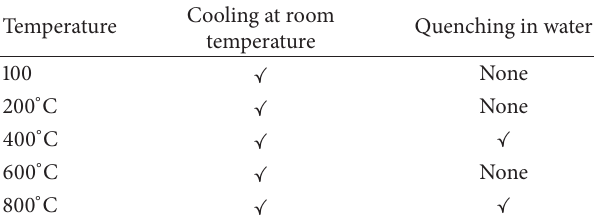
Table 2: Two cooling regimes for different curing-age ECC speci-